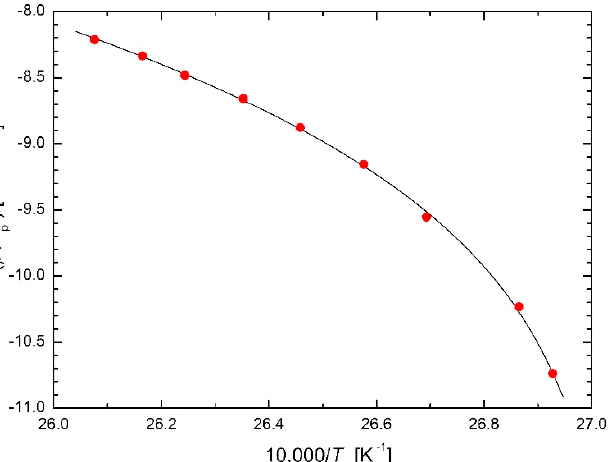
Figure 2. Kissinger plot for Ni-Mn-In-Mg shape memory alloy [5] using Equation (7) as regression function.